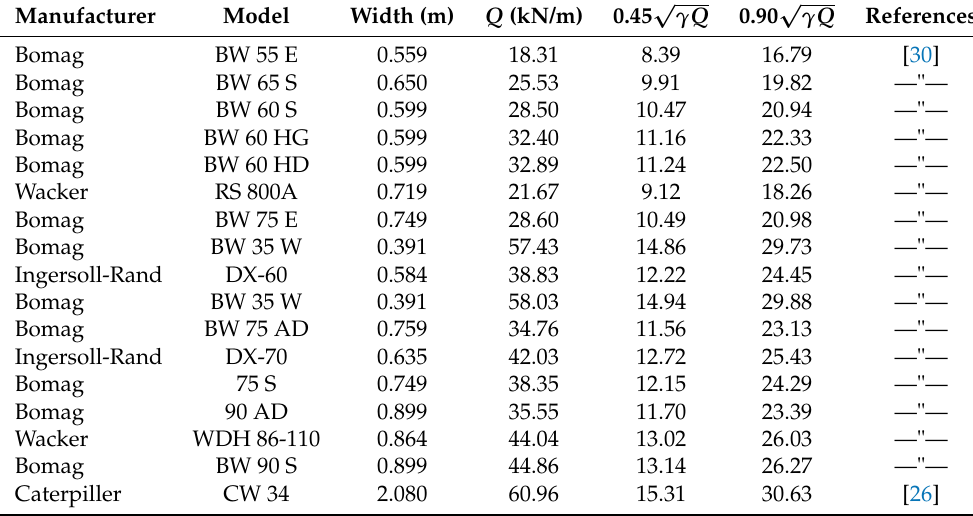
Table 2. Data for vibratory roller soil compactors (heavy